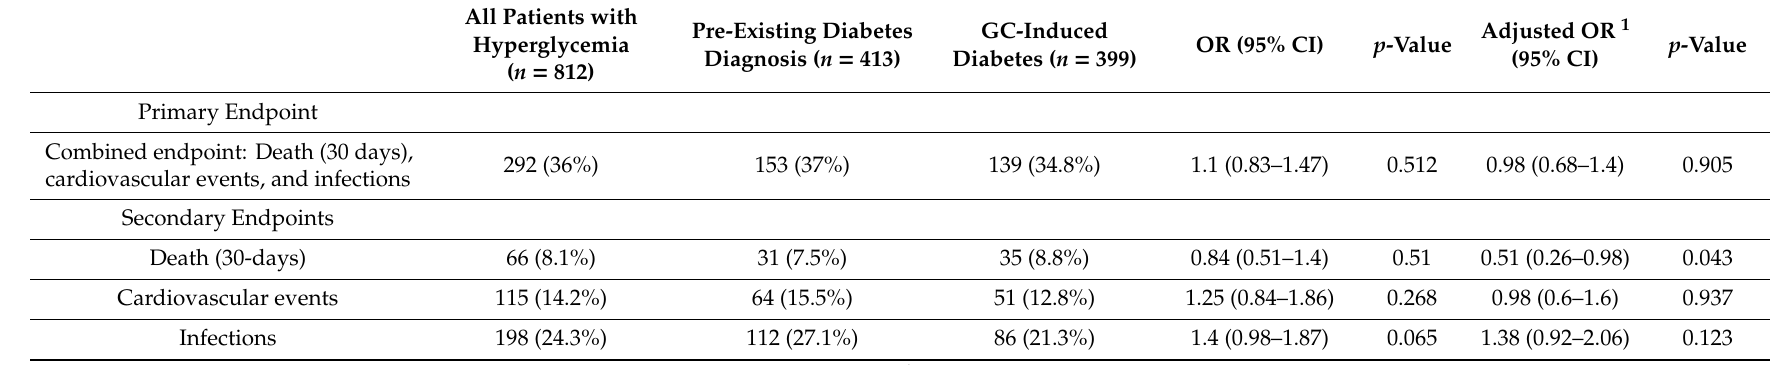
Table A4. Main results of primary and secondary endpoints in pre-existing diabetes vs. GC- induced diabetes. All Patients